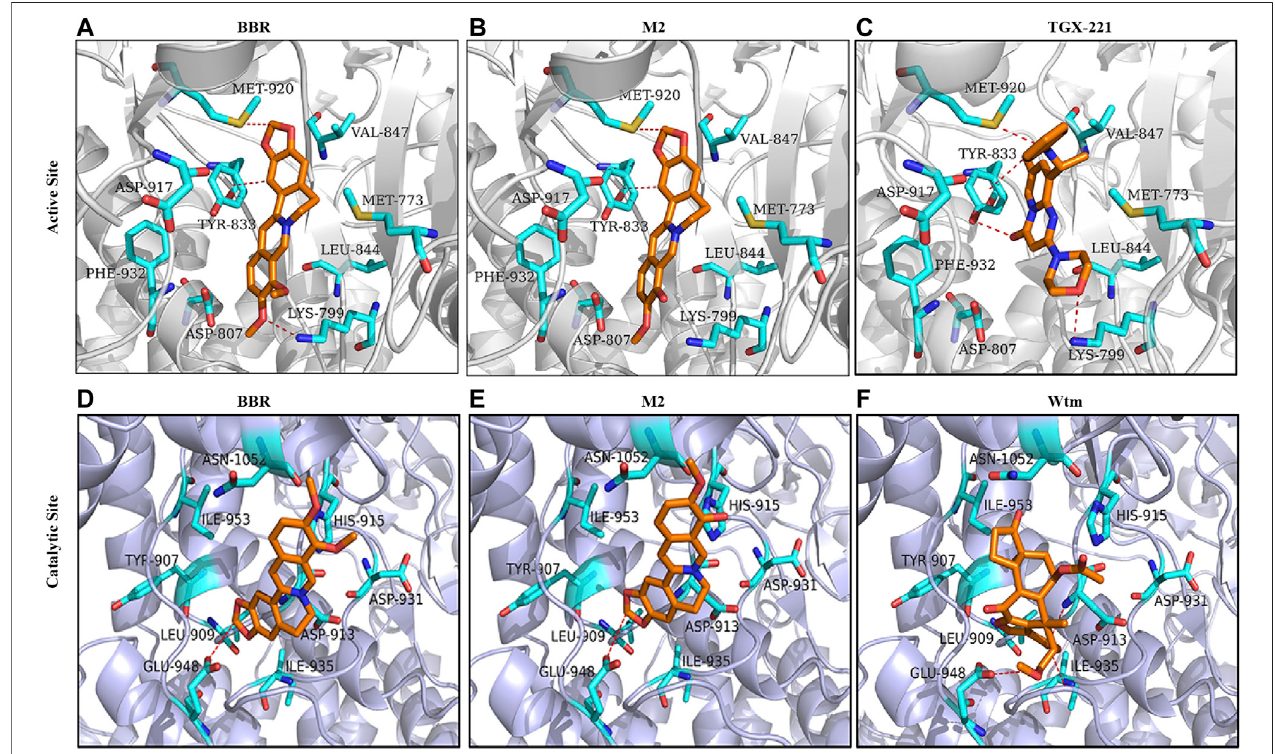
FIGURE 7 | Molecular docking. Molecular docking was performed to study the 3D binding modes of BBR and M2 with the active site (A-B) and the catalytic site (D-E) of class I PI3K p110 β . The binding modes of TGX221 with the active site (C) and Wtm with the catalytic site (F) are also presented. All studied compounds are in orange, the surrounding residues in the binding pockets are in cyan, and the backbone of the receptor is depicted as grey or lavender cartoon.